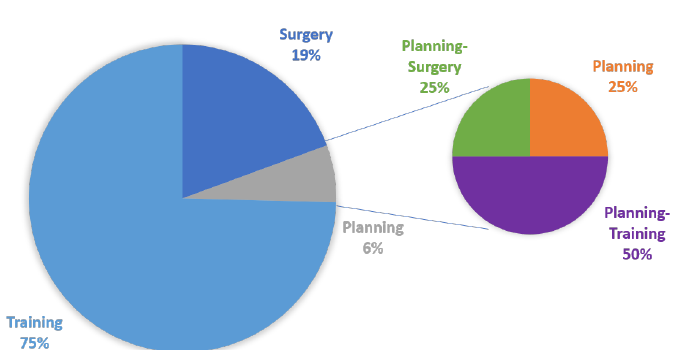
Figure 3. Distribution of the analyzed papers in terms of their type of use (training, surgery, and planning).